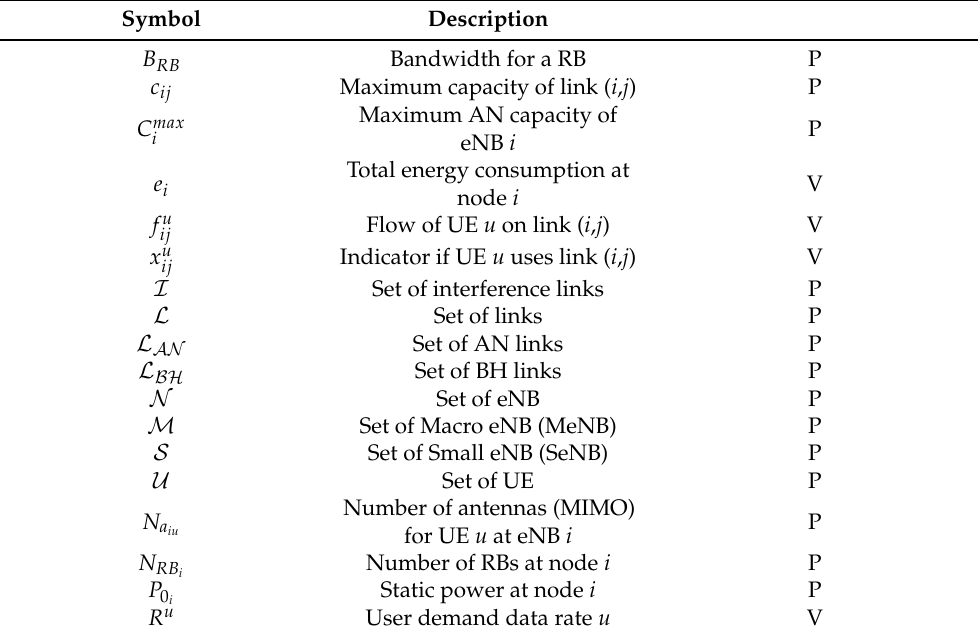
Table 2. Parameters (P) and variables (V) used in the model. Symbol